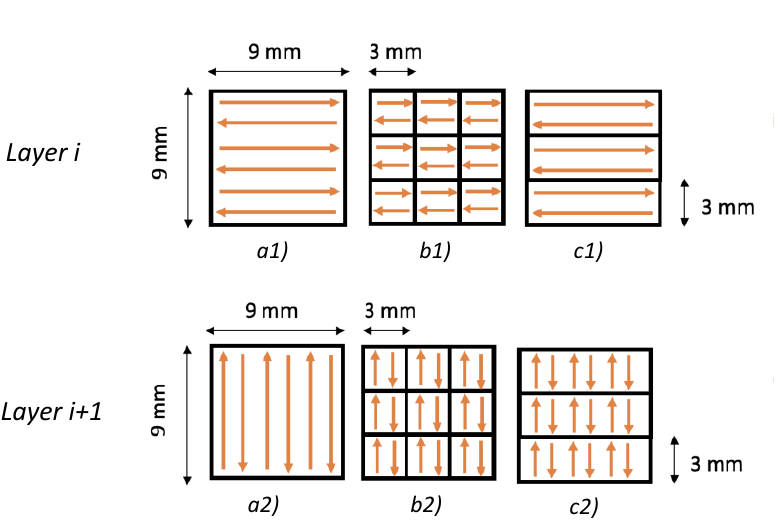
Figure 1. Laser pattern characteristics for two subsequent layers: ( a1 ) Linear, ( b1 ) chess 3 × 3 mm, and ( c1 ) strip 3 mm at layer i-th; ( a2 ) Linear, ( b2 ) chess 3 × 3 mm, and ( c2 ) strip 3 mm at layer i+1-th .